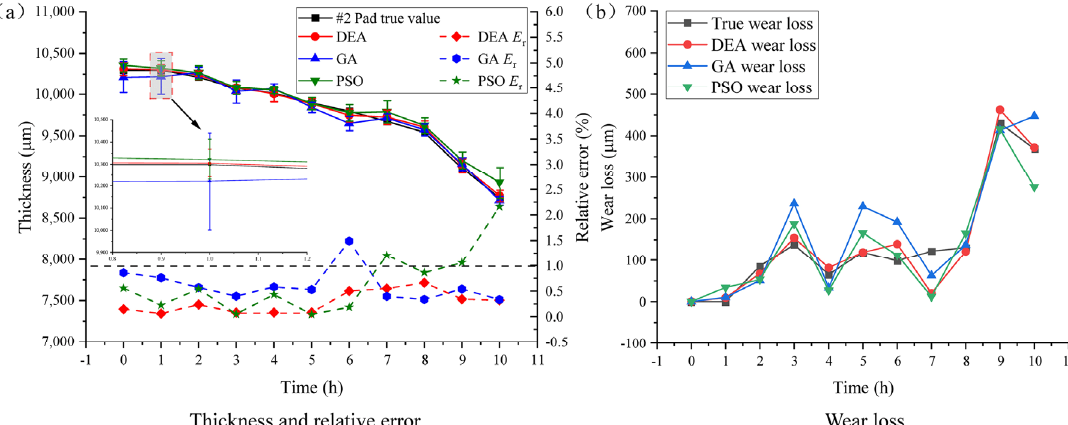
Fig. 27 Identification results of different intelligent algorithms of the #2